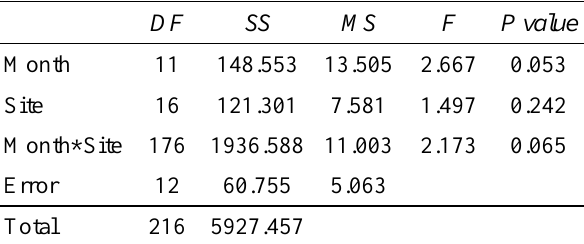
Table 5: Results of two-way ANOVA comparing